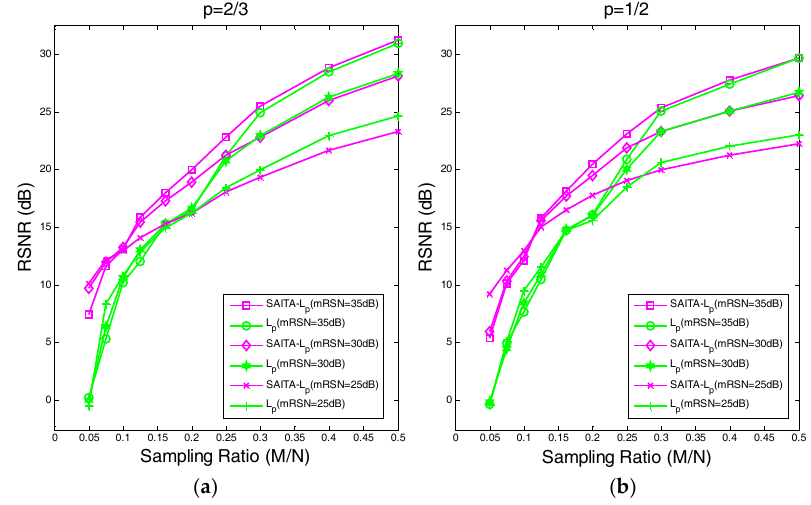
Figure 5. The RSNR performances of the proposed SAITA- L p algorithm and the L p algorithm with mRSN ∈ { 25, 30, 35 } dB. ( a ) p = 1/2. ( b ) p = 2/3.